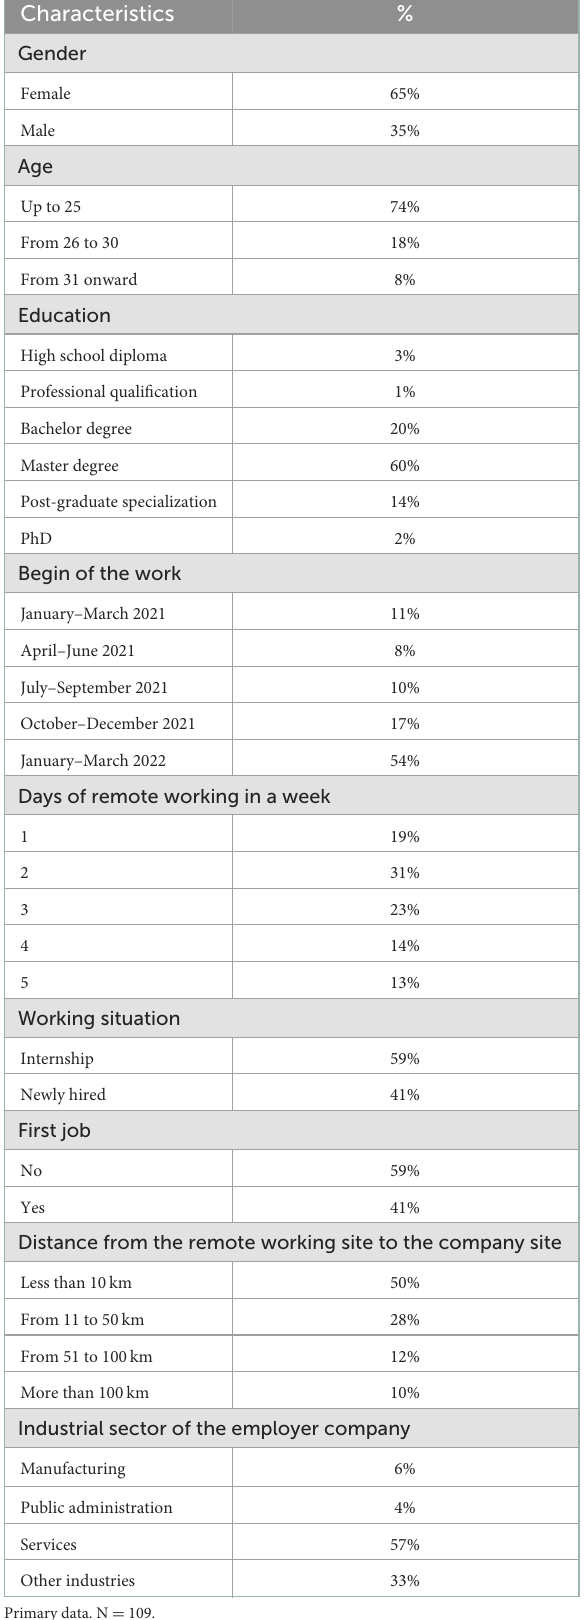
TABLE 1 Sample key characteristics and remote working condition.